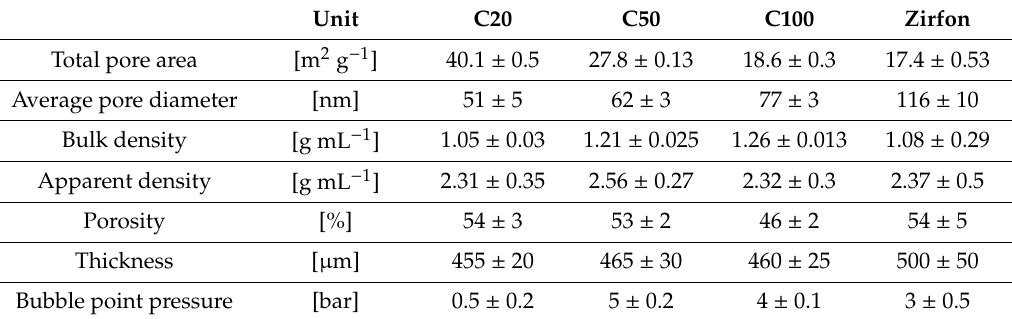
Figure 2. ( a ) Hg incremental intrusion volume curves and ( b ) bubble point pressure of the composite separators and Zirfon separator. Table 2. Physical properties of composite separators and